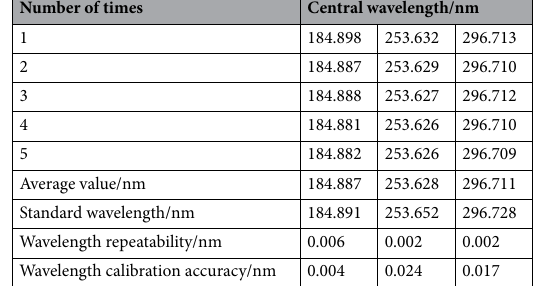
Table 2. Measurement results of wavelength repeatability and wavelength calibration